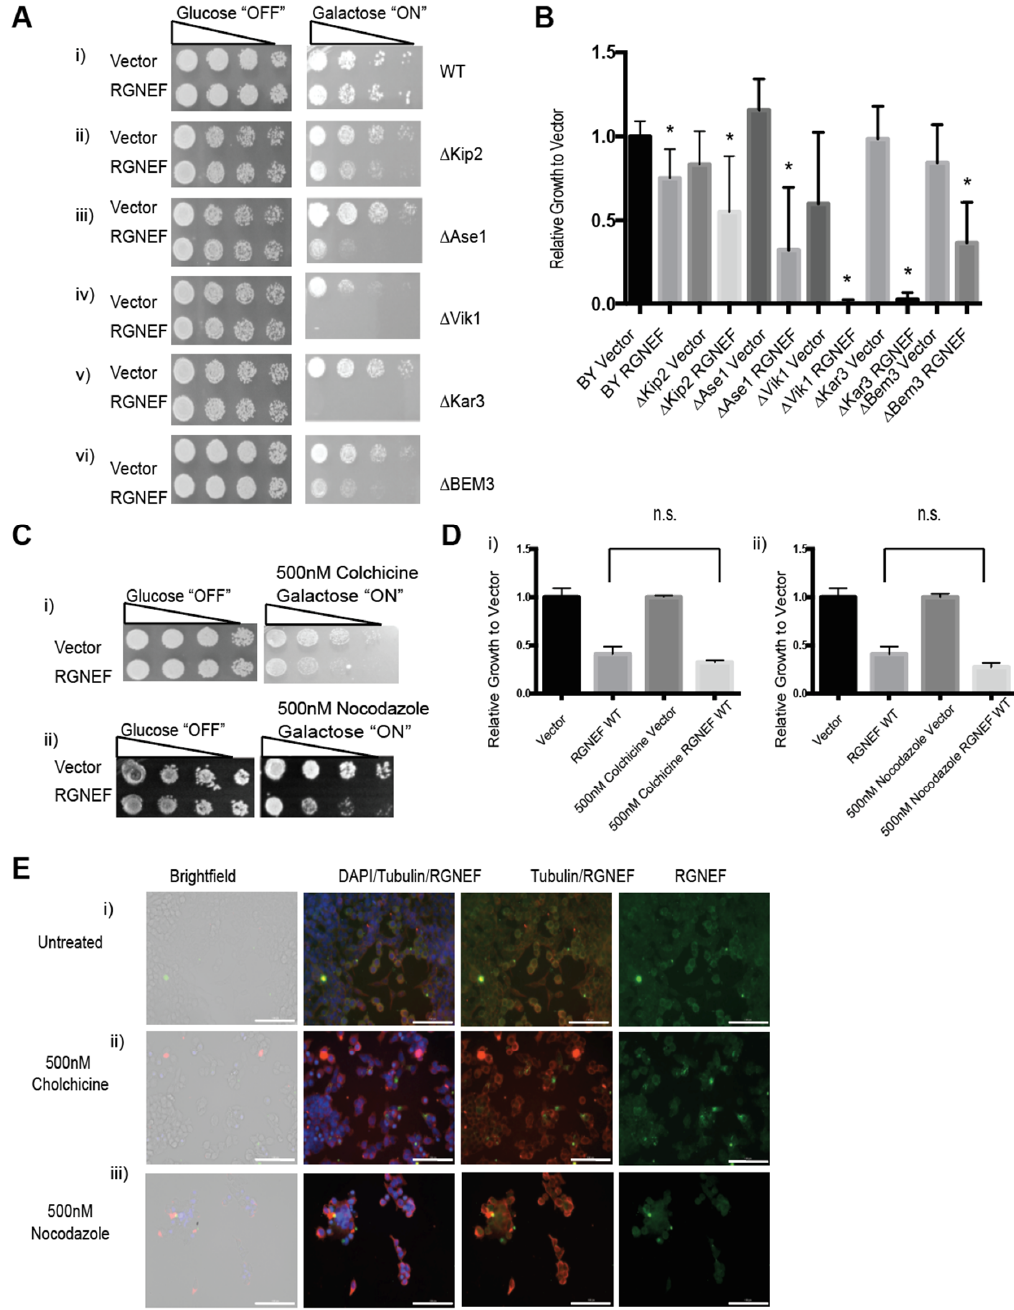
Figure 8. Genetic interaction between RGNEF and microtubule-associated genes. ( A ) Growth assay of yeast cells expressing full length wild type RGNEF in a wild type yeast strain and microtubule-associated gene deletion strains: (i) WT strain, (ii) ∆Kip2, (iii) ∆Ase1, (iv) ∆Vik1, (v) Kar3, and (vi) ∆BEM. ( B ) Quantification of growth assay as shown in A. Error bars represent standard deviations. * indicates statistical significance ( p < 0.05) compared to vector control. ( C ) Growth assay of yeast cells expressing wild type RGNEF in a wild type yeast strain grown on inducing media containing (i) 500 nM Colchicine and (ii) 500 nM Nocodazole. ( D ) Quantification of growth assays as shown in C. Error bars represent standard deviations, n.s. indicates not statistically different. ( E ) Immunofluorescence microscopy of partially differentiated Neuro-2a cells detecting endogenous RGNEF: (i) untreated cells, (ii) 500 nM colchicine, and (iii) 500 nM Nocodazole. Error bars represent standard deviations. (20× magnification, scale bar = 100 μm).